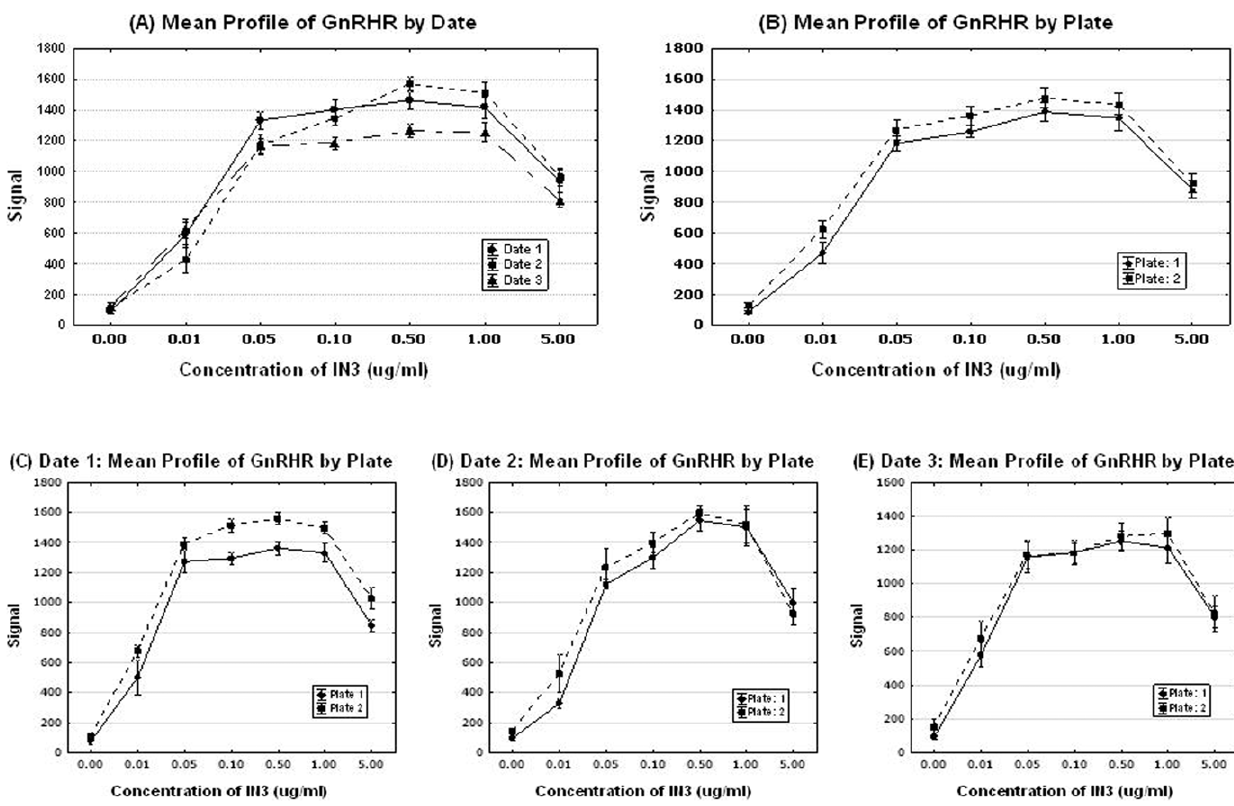
Figure 3. Mean profiles of signals by day and plate for the GnRHR pharmacoperone assay. Estimated equation for the model has a maximum gain of activity in stable HeLa cells at the 0.5 m g/ml dose by using the first order derivative.